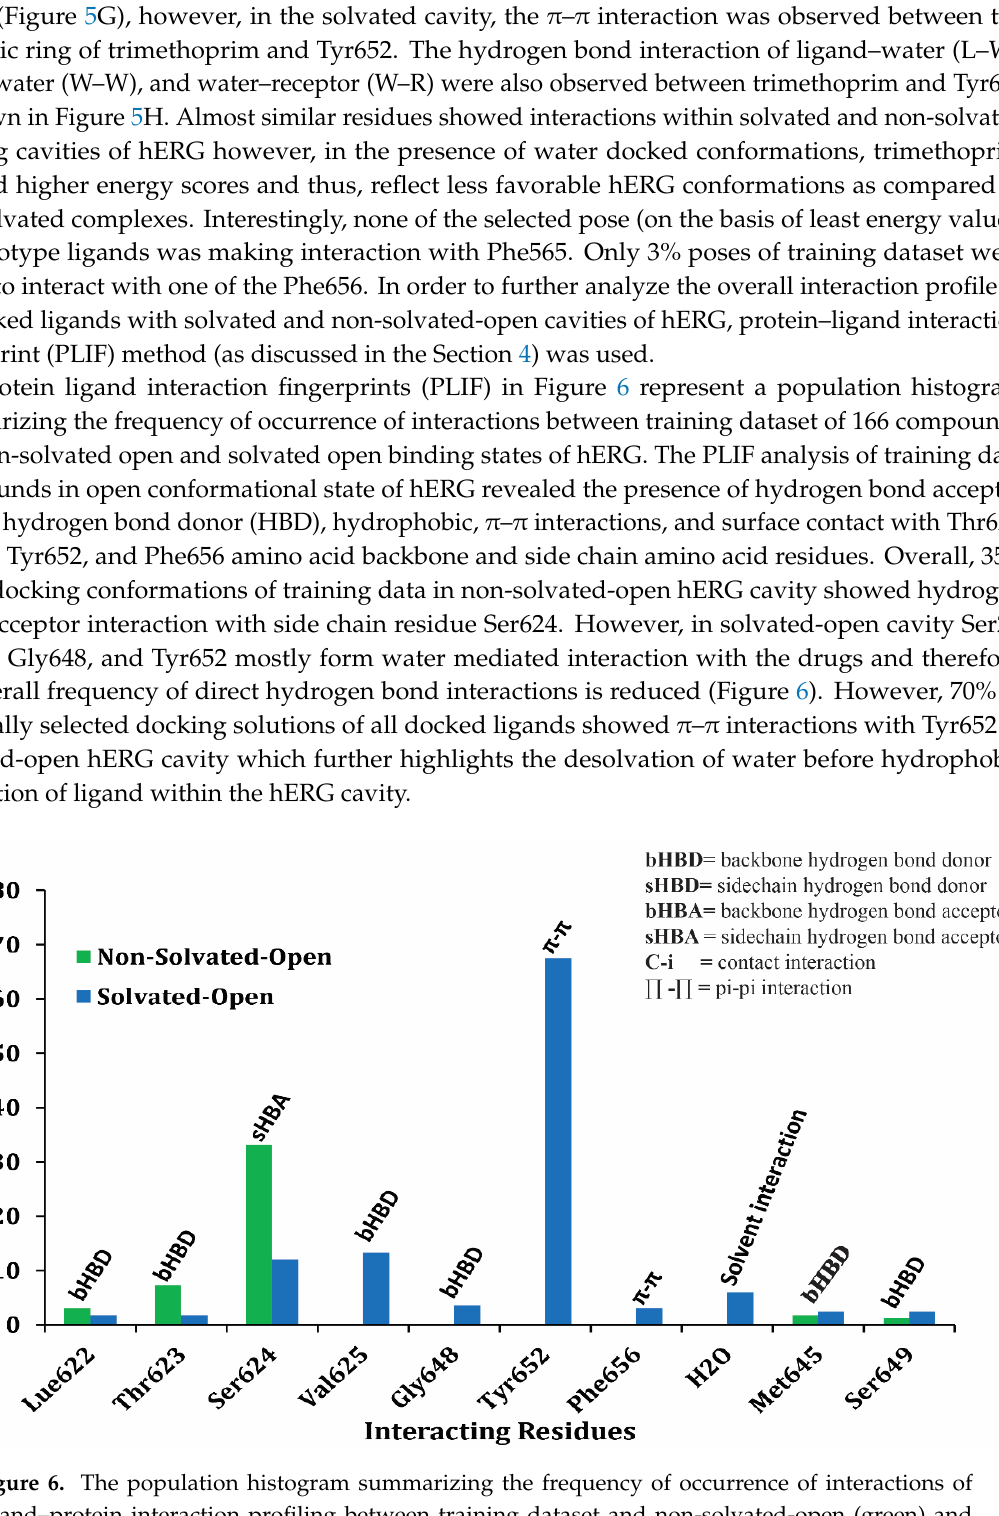
hydrogen bond with Leu622 and Thr623 in non-solvated hERG cavity. ( D ) Docked E4031 final pose showing hydrogen bond and water mediated interactions with hydrophobic interaction with Ser624. ( E ) Dofetilide docked in non-solvated-open binding cavity of hERG showing hydrogen bonding with Ser621 and Thr623. ( F ) Final pose of dofetilide showing water mediated interactions with Ser624 and hydrogen bonding with Ser621 and Thr623. ( G ) Final pose of docked trimethoprim in non-solvated open cavity showing hydrogen bonding with Thr623 and Ser624. ( H ) Trimethoprim final pose